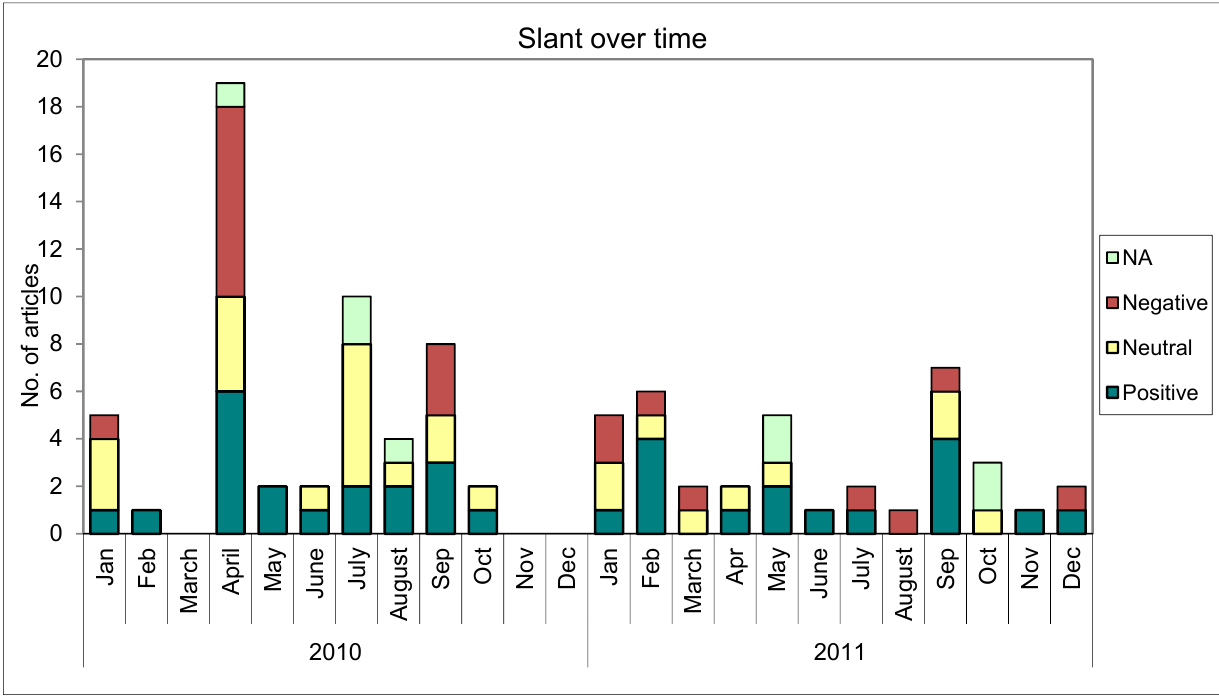
Figure 2. Slant over